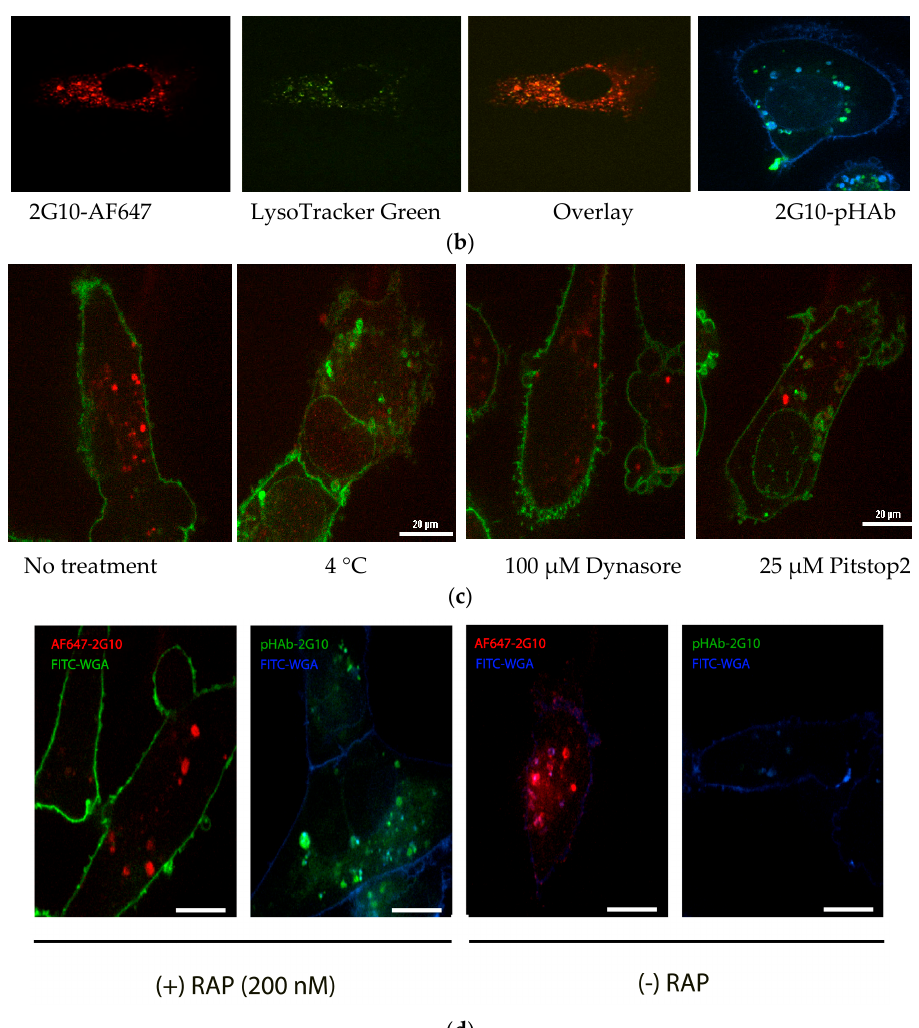
Figure 3. 2G10 internalization by MDA-MB-231 cells. ( a ) Flow cytometry analysis of 10 µg/mL 2G10 internalizing at 37 °C into MDA-MB-231 cells at various timepoints. Positive binding is indicated by a rightward shift in fluorescence intensity of histogram. ( b ) Internalization of 2G10-AF647 or 2G10-amine-pHAb monitored using confocal microscopy. MDA-MB-231 cells were incubated for 1 h at 37 °C with 10 µg of 2G10 IgG conjugated to Alexa Fluor 647 (red, 2G10-AF647) and lysosome dye LysoTracker Green DND-26 (green), or with 10 µg 2G10-amine-pHAb. Excess antibody was washed away and cells were imaged on Yokagawa CSU22 spinning disk confocal (Ex/Em: 561/580 LP nm). The top panel shows the confocal analysis showing 2G10-AF647 (red) localized to the lysosome, which is stained with a lysosome-specific green dye. The overlay image showed high colocalization of 2G10-AF647 into the lysosome (yellow). ( c ) The effect of endocytosis inhibitors on 2G10-AF647 internalization was monitored using confocal microscopy. MDA-MB-231 cells were incubated for 1 h at 37 °C with 10 µg of 2G10-AF247. Cell membranes were visualized with wheat germ agglutinin (WGA)-AF488 (green) which binds to cell membrane. Excess antibody was removed and replaced with pH 8.0 buffers and imaged on Yokagawa CSU22 spinning disk confocal (Ex/Em: 561/580 LP nm). ( d ) Antibody internalization to MDA-MB-231 cells in the presence or absence of endocytosis inhibitor RAP (200 nM). 2G10-AF647 (red) or 2G10-pHAb is used for antibody tracking. WGA-AF488 (green) or WGA-AF350 (blue) binds to cell membrane.